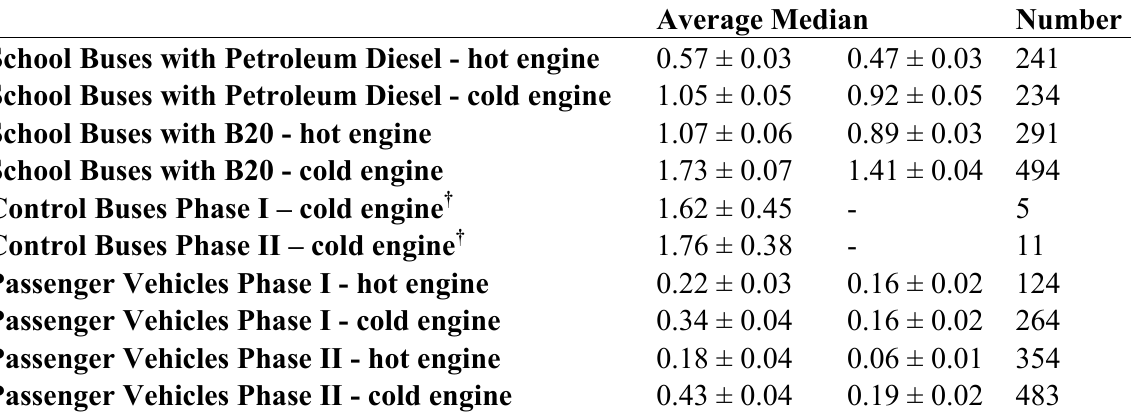
Table 5. Particulate matter emission factors (±68% confidence limits) for the school busses powered by petroleum diesel and a B20 biodiesel blend (20% biodiesel and 80% petroleum diesel) and for passenger vehicles (mostly gasoline cars) for both cold engine and hot engine conditions. The control buses were powered with B20 since few months before the beginning of the experiment.